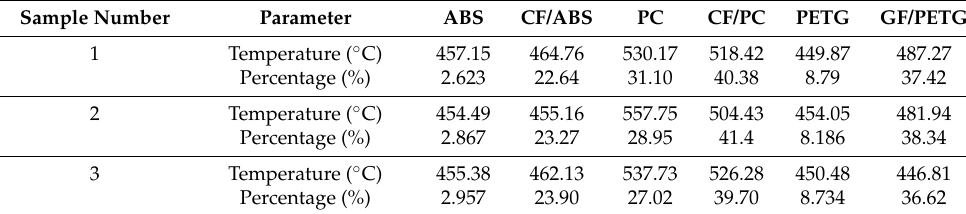
Table A5. TGA T crit from